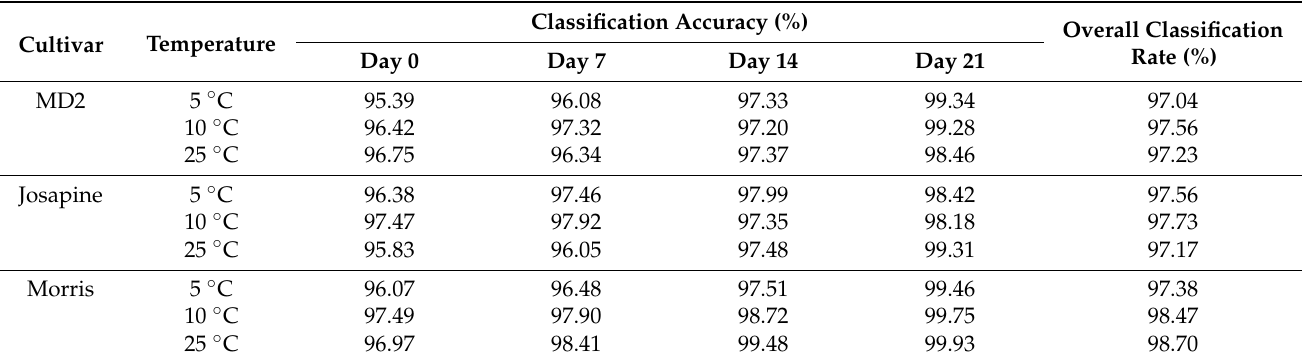
Table 5. Classification performance of pineapple cultivars at different storage days and temperatures using k-nearest neighbour.